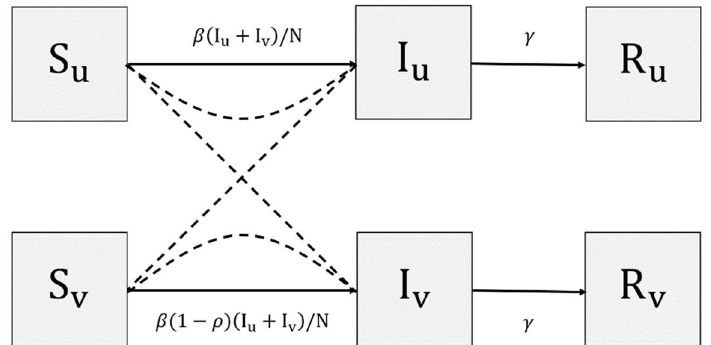
Figure 1. State-flow diagram of { SIR } uv . Solid lines represent direct flow, while dashed lines represent interactions of states.